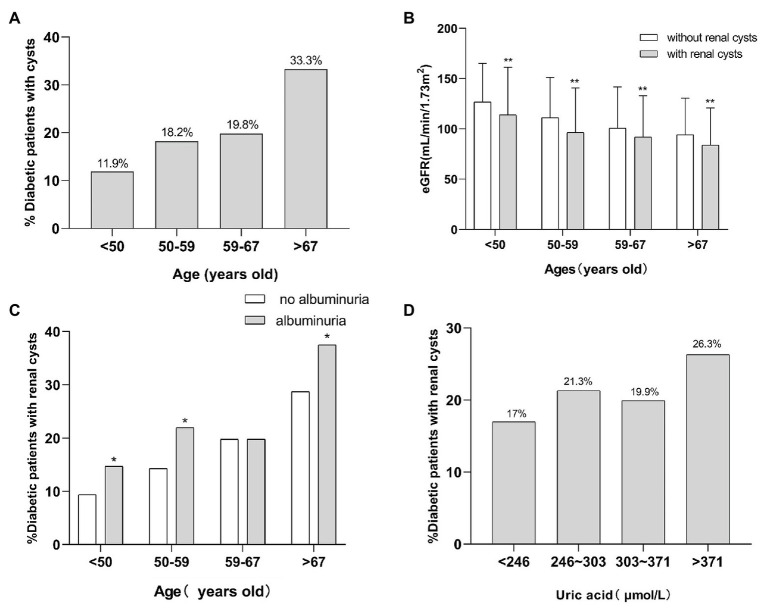
The relationship of SRCs with age, eGFR, proteinuria, and uric acid. (A) Incidence of SRCs in four age groups in patients with T2DM. (B) The eGFR of patients with T2DM with SRCs and without SRCs at different ages. (C) The incidence of SRCs in patients with T2DM with proteinuria and without at different ages. (D) The incidence of SRCs in patients with type 2 diabetes with a high level and normal level of uric acid at different ages. *p < 0.05 and **p < 0.01. Error bars indicate standard errors. T2DM, type 2 diabetes mellitus; SRCs, simple renal cysts; eGFR, estimated glomerular filtration rate.